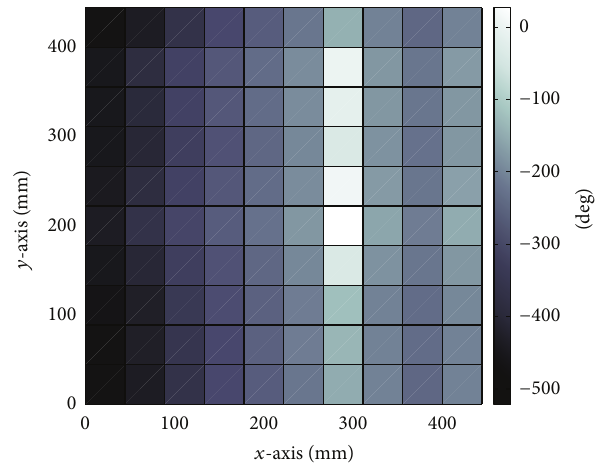
Figure 2: An instance of two-dimensional nonuniform distribution of reflection phase in degree, which is expected to significantly reduce the specular reflection of planar conducting